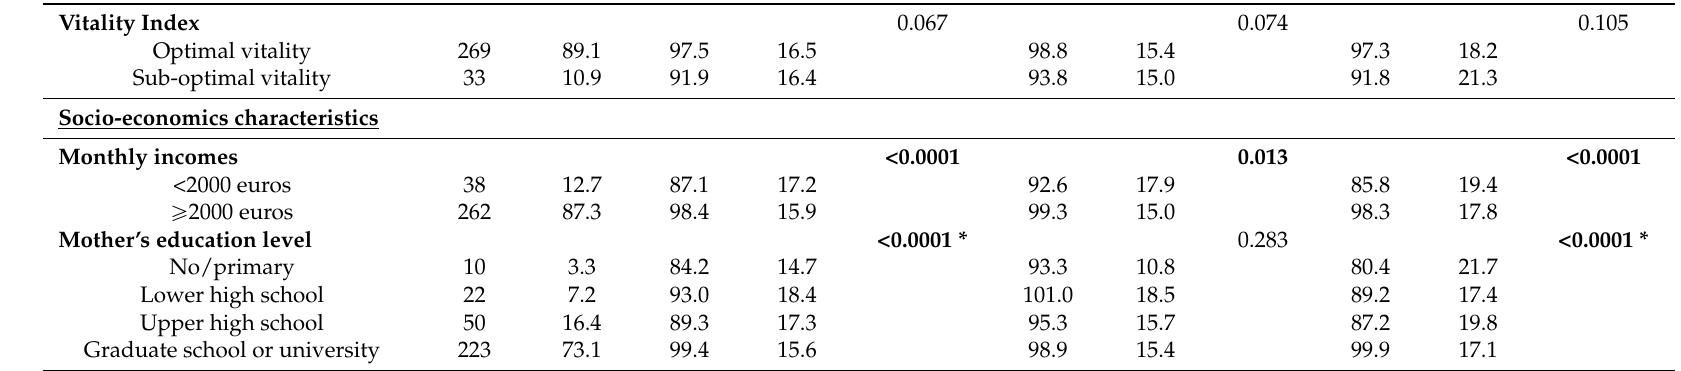
Table 3. Association of cognitive scores at preschool age with infant, maternal, and household characteristics: continuous variables. PsychoTSH study, Belgium, 2008–2014.